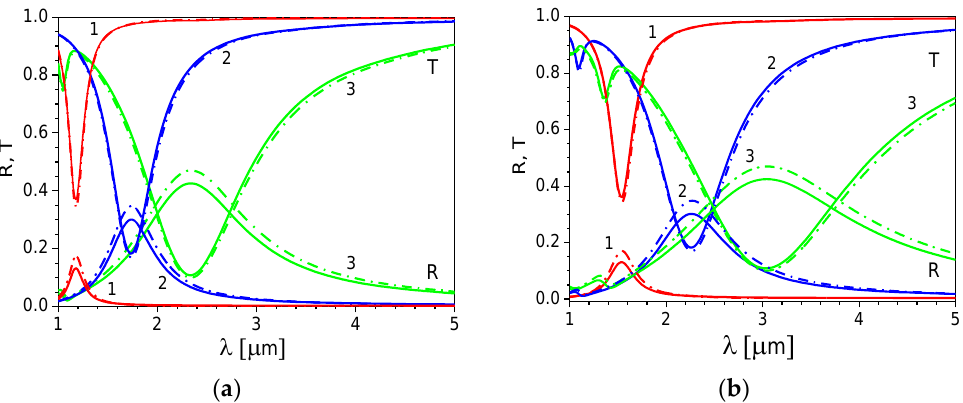
Figure 3. Reflection and transmission spectra of the ITO nanoribbon grating for different values of the ribbon aspect ratio d / Λ and two orientations of the nematic director. Grating spacing: ( a ) Λ = 300 nm and ( b ) Λ = 500 nm; d / Λ = 0.25—curves 1, d / Λ = 0.5—curves 2, and d / Λ = 0.75—curves 3; planar director orientation ( ψ = π / 2)—solid lines and homeotropic director orientation ( ψ = 0)—dotted-dashed lines. τ = 6.7 fs and n 2 D = 5 × 10 19 m − 2